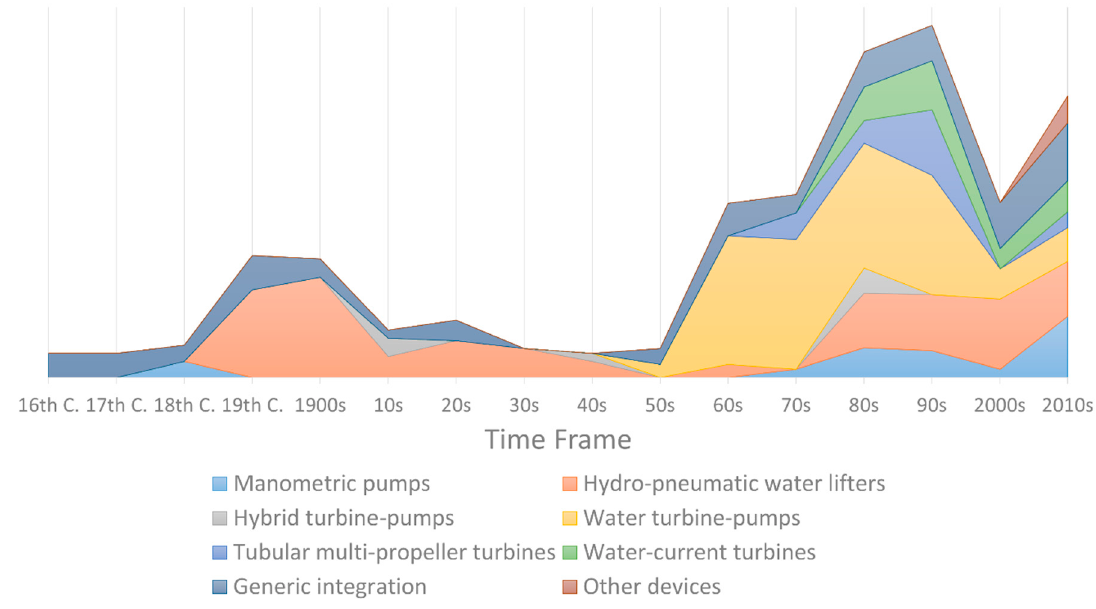
Figure 15. Number of reported cases of HPP technologies over time, depicted proportionally based on a logarithmic scale. The different colored areas represent each of the HPP classes.